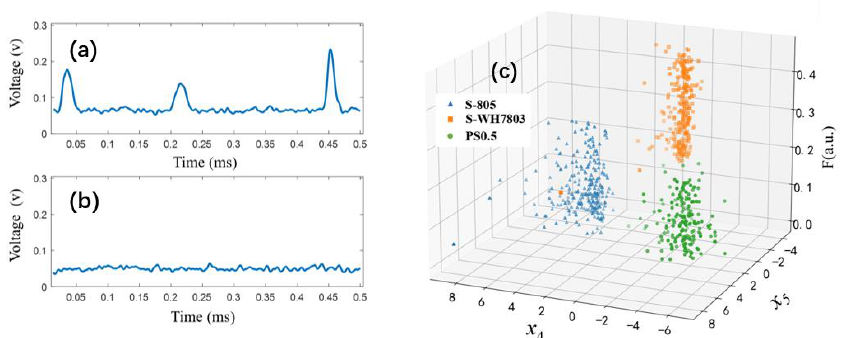
Figure 5. ( a ) Measured voltage signals of a PS microspheres of 0.5 μm (PS0.5). ( b ) Measured voltage signals of pure water (PW). ( c ) Distributions of three particle categories using both polarization parameters and fluorescence.